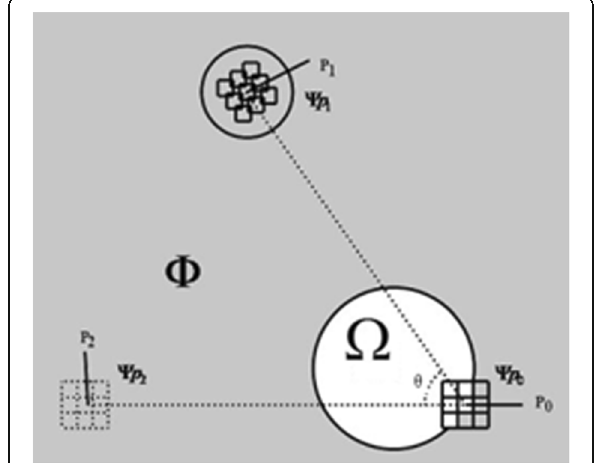
Fig. 7 A diagram of symmetrical exemplar in arbitrary directions